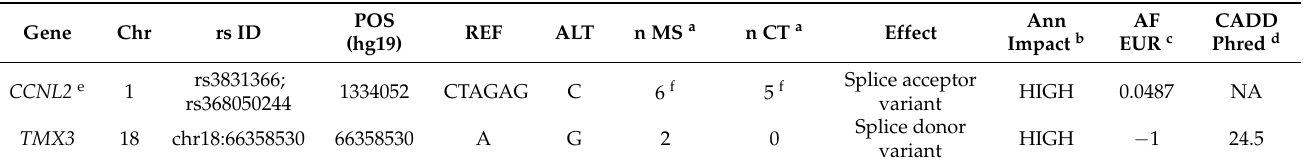
Table 2. Genes presenting with only one low-frequency functional variant in a multiplex sample set. For these genes, the burden test was not performed, as they only displayed one rare variant with a predicted functional effect.